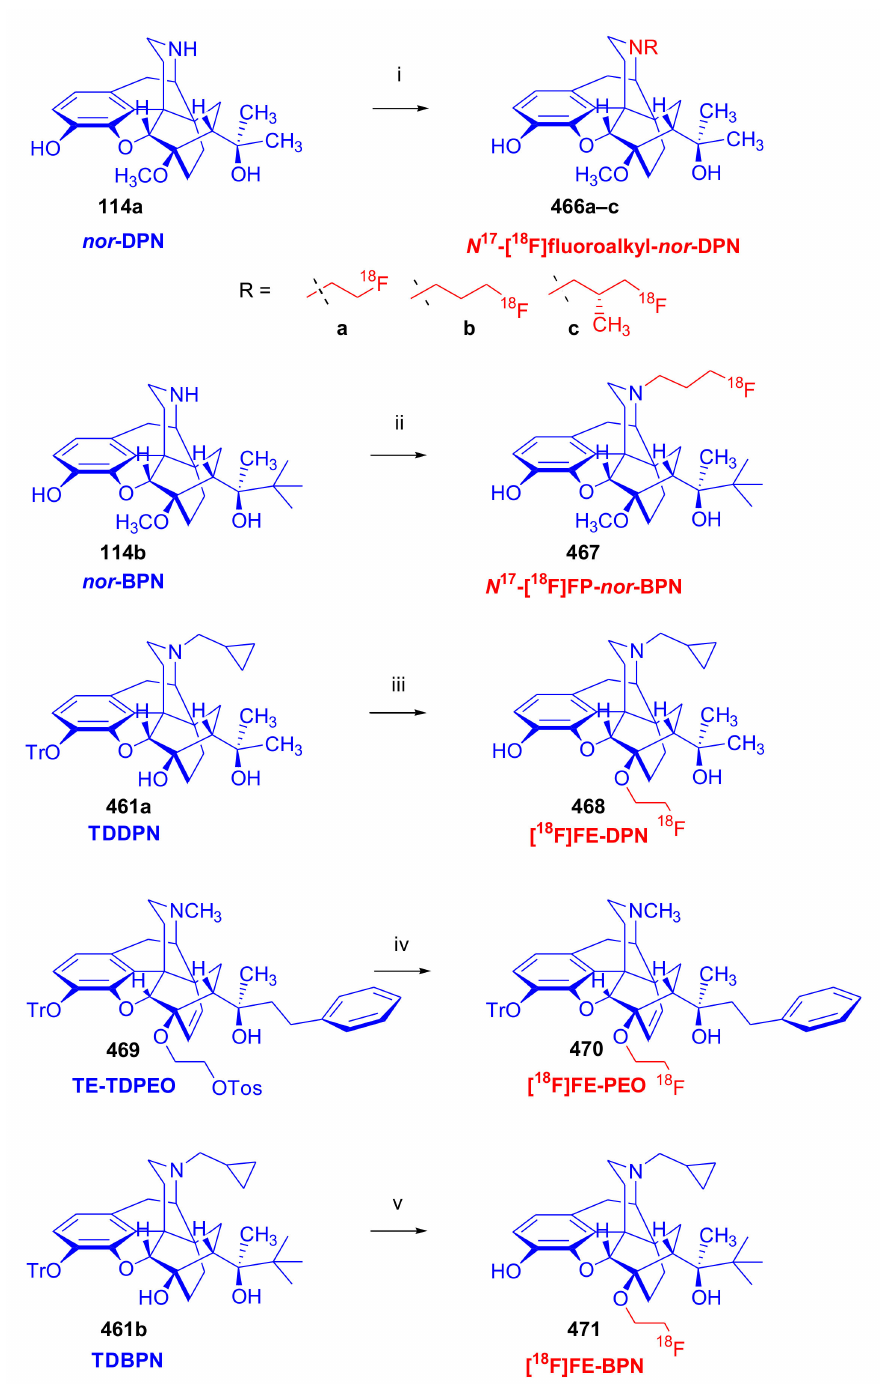
Figure 115. Synthesis of selected 18 F-labeled orvinol derivatives. Reagents and conditions : (i): [ 18 F]F(CH 2 ) n I, NaH, 130 ◦ C, 30 min; (ii): [ 18 F]F(CH 2 ) 3 I, NaHCO 3 , 110 ◦ C, 20 min; (iii): (1) [ 18 F]FEOTos, NaH, 100 ◦ C, 5 min; (2) 2M HCl, 100 ◦ C, 2 min.; (iv): (1) [K + ⊂ K222] 18 F − , CH 3 CN, 90 ◦ C, 10 min, (2) 1M HCl, in EtOH, 40 ◦ C, 5 min; and (v): (1) [ 18 F]FEOTos, 100 ◦ C, 10 min, (2) 2M HCl, 40 ◦ C, 5